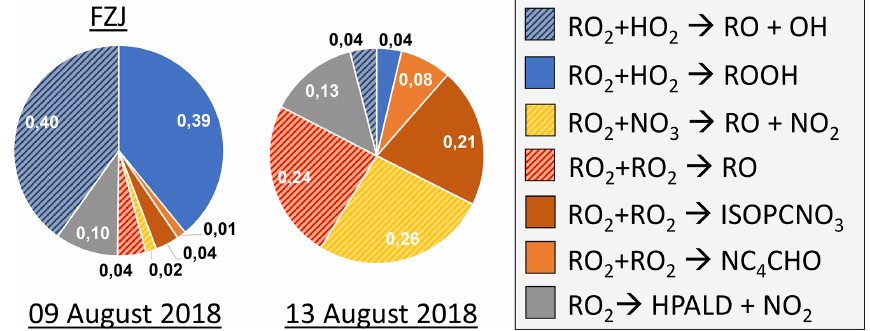
Figure A4. Relative distribution of loss rates of nitrate RO 2 for the experiments on 9 and 13 August 2018 (Experiments 1 and 4) if the FZJ-NO3 mechanism is applied and HO 2 is not constrained to measured values. Total RO 2 concentrations and concentrations of speciated nitrate RO 2 were taken from model